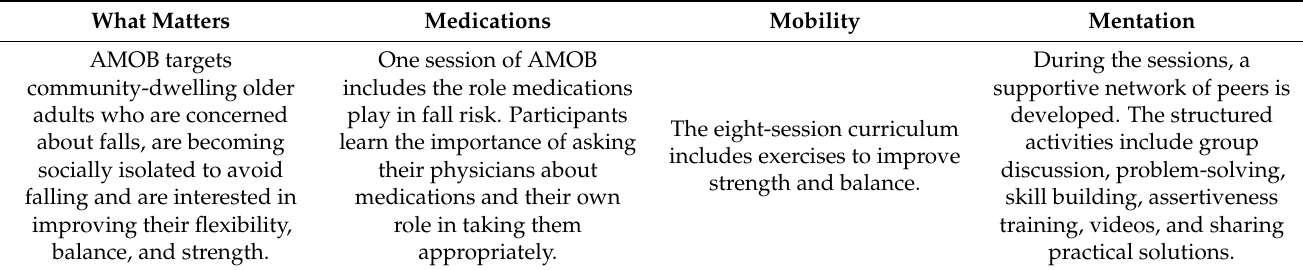
Table 1. Age-Friendly Health System 4Ms components of A Matter of Balance (AMOB) model.